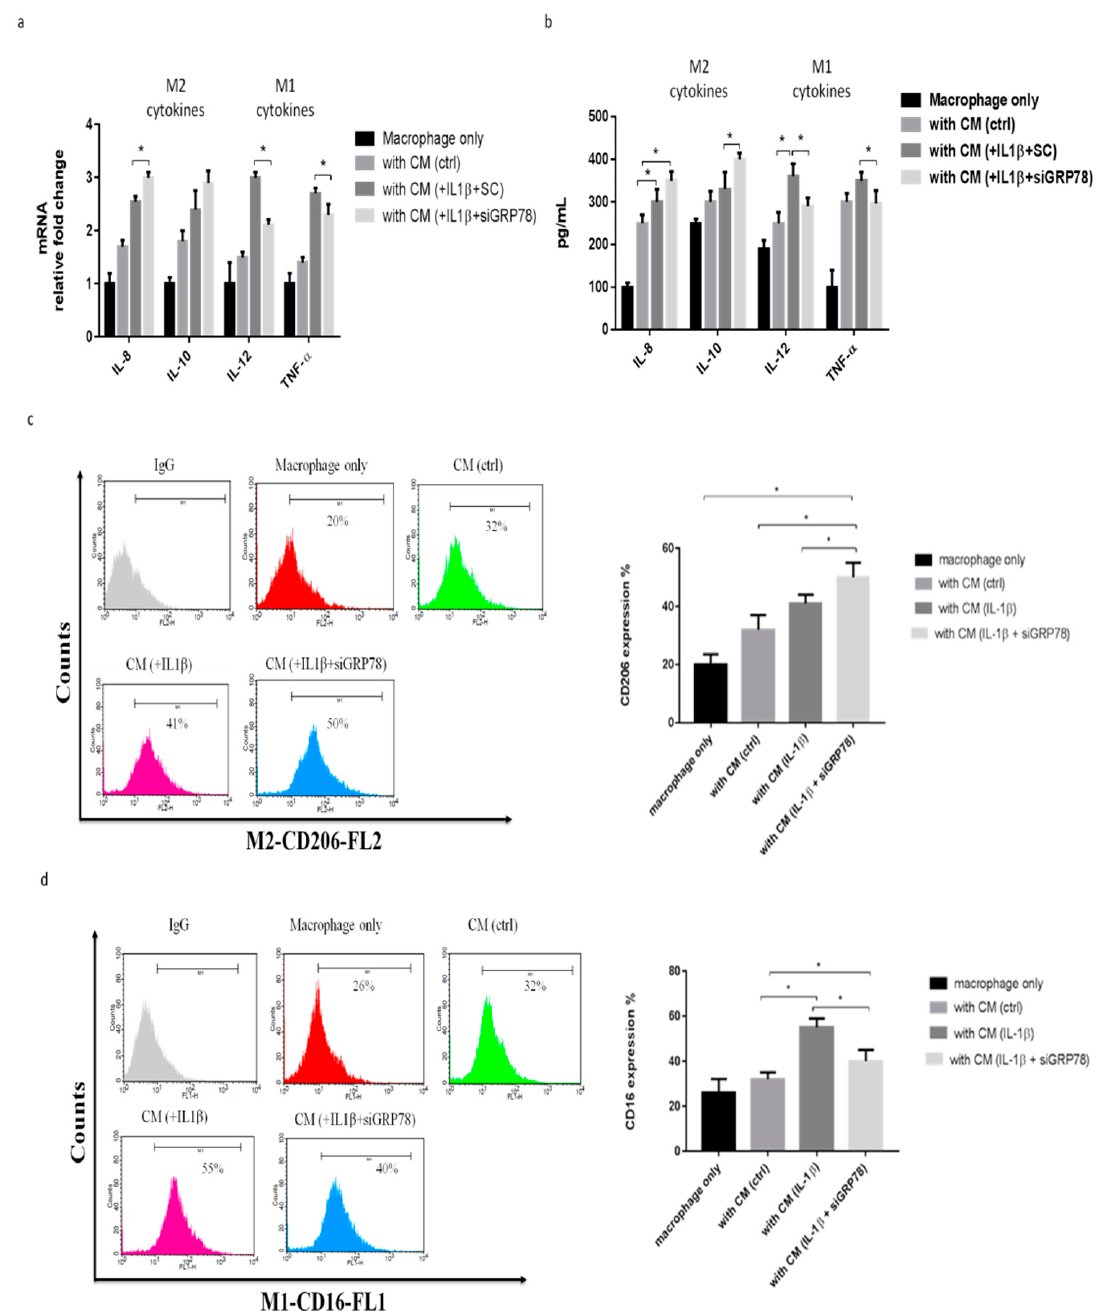
Figure 4. Knockdown GRP78 in synoviocytes regulated macrophage polarization to promote the M2 phenotype, using knockdown GRP78 in IL-1 β (10 ng/mL) treated synoviocytes. Then, the CM was collected from synoviocytes to treat THP-1 cells. ( a ) Quantitative PCR analysis of IL-8, IL-10, IL-12, and TNF- α . ( b ) ELISA analysis of IL-8, IL-10, IL-12, and TNF- α . ( c , d ) Flow cytometry analysis of the expression of CD206, a marker of M2, and the expression of CD16, a marker of M1. Data are expressed as mean ± SD, * p < 0.05. IgG as a negative control. The data presented are representative of three independent